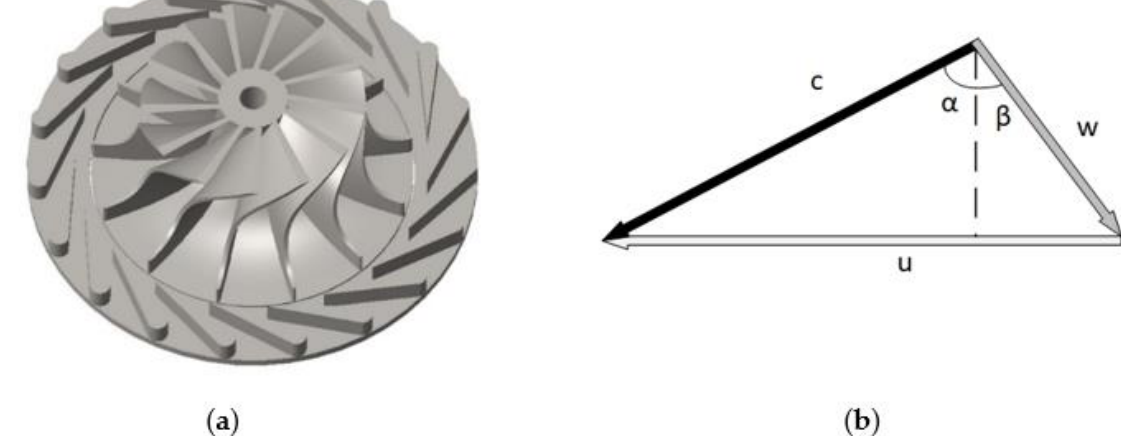
Figure 1. A radial-inflow turbine rotor geometry and stator vanes ( a ) and example of a typical rotor inlet velocity triangle ( b ).